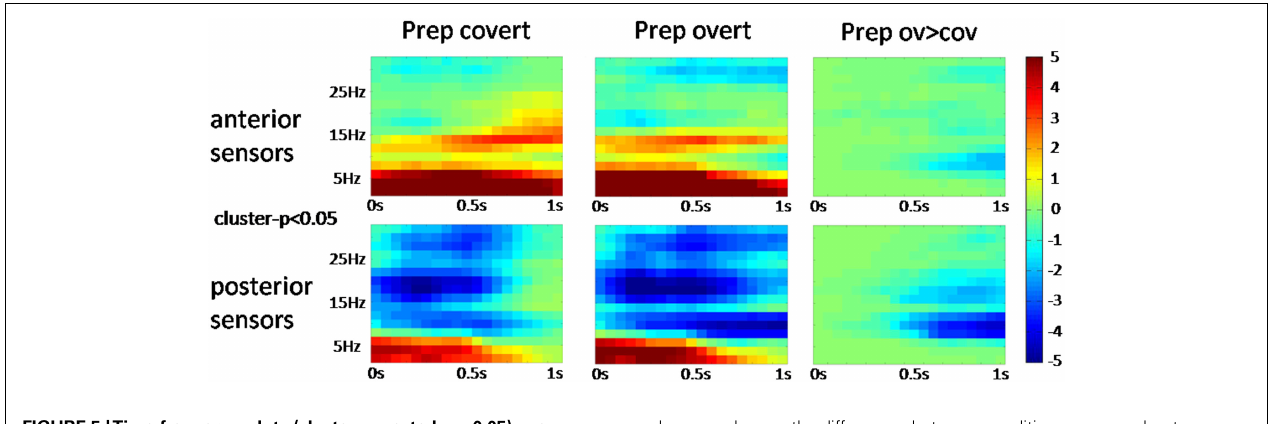
FIGURE 5 |Time-frequency plots (cluster corrected p < 0.05) over averaged anterior and posterior sensors for the different conditions. Task preparation is associated with sustained activity